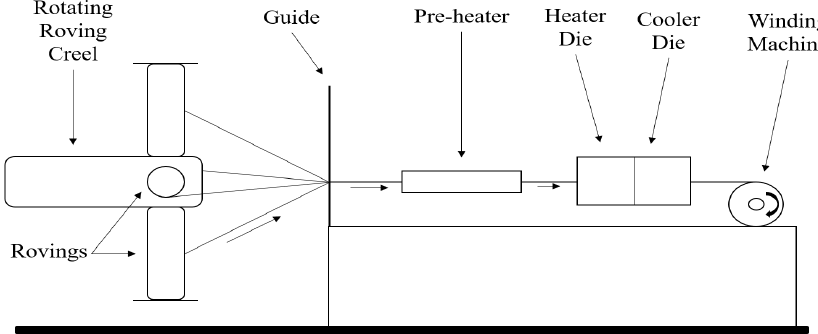
Figure 3. Illustration of the setup used in the experimental process.